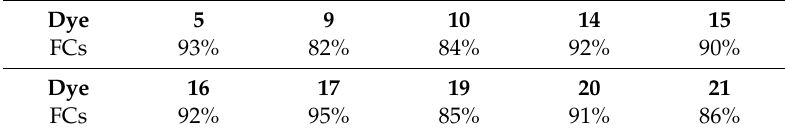
Table 1. Summary of the final acrylate function conversions (FCs) at 405 nm for Ebecryl 40 using three-component photoinitiating systems: dyes (0.1%, w / w), iodonium salt (Speedcure 938, 2%, w / w) and amine (Speedcure EDB, 2%, w /